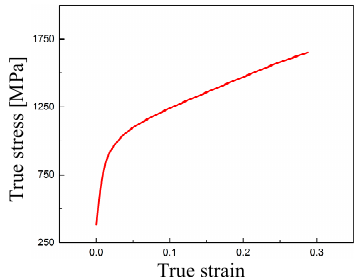
Figure 5. Schematic diagram for the tool-edge passivation method at di ff erent depression angles, i.e., Figure 6. Schematic diagram for the tool-edge passivation method at different depression angles, i.e., 0 ◦ , 45 ◦ , and 60 ◦ . 0°, 45°, and 60°.